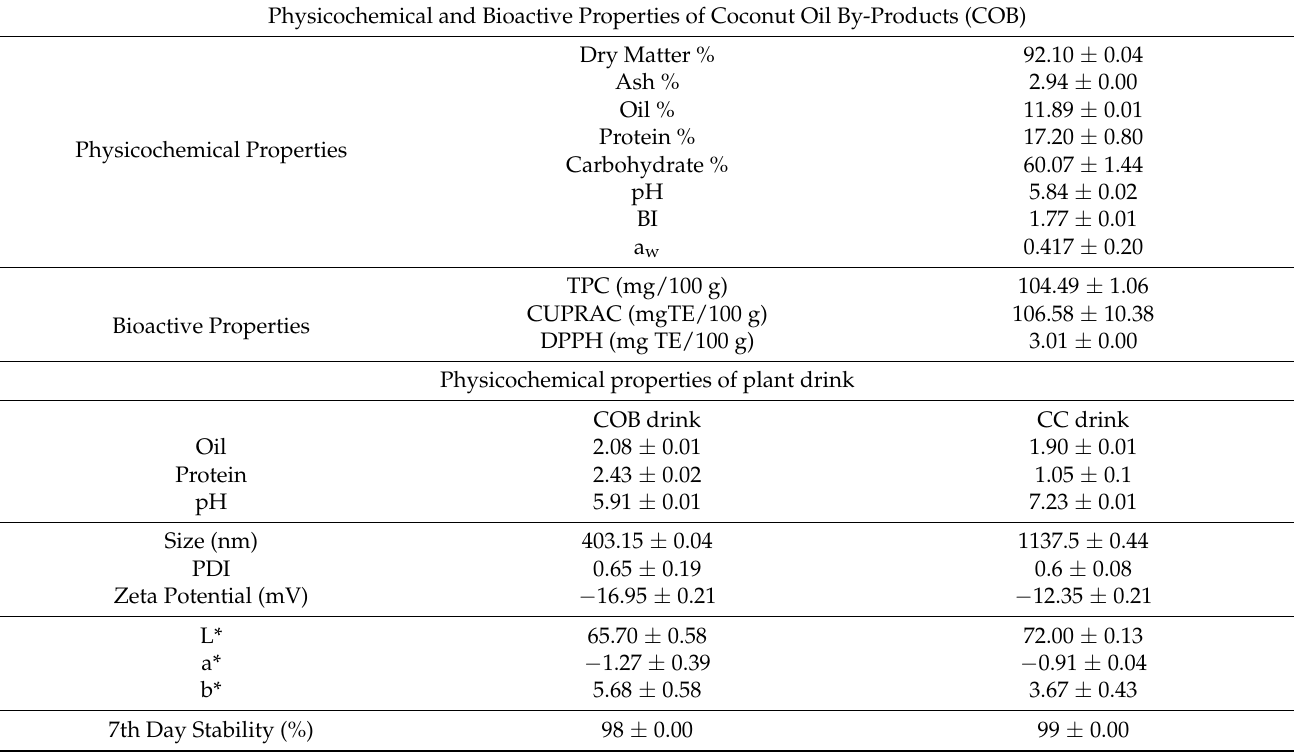
Table 1. Physicochemical properties of coconut oil by-products and plant drink